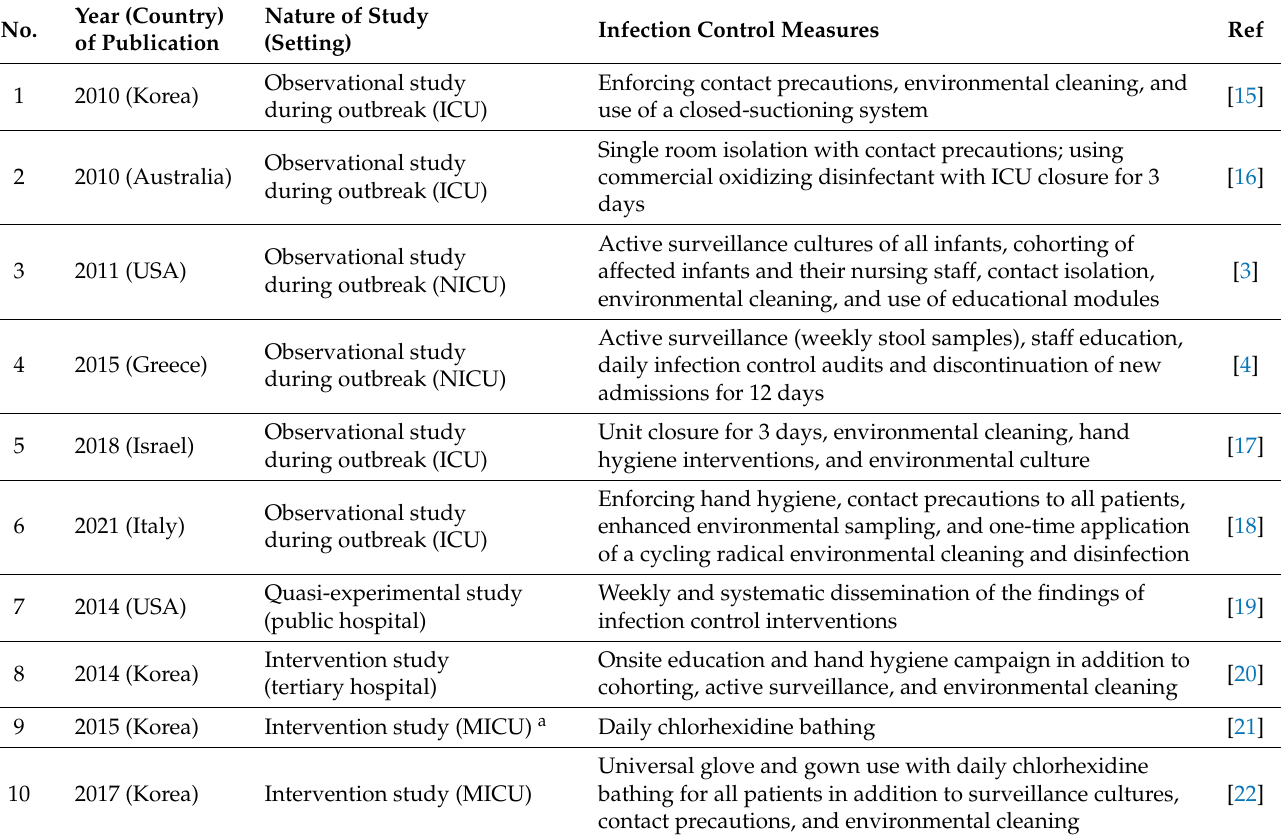
Table 2. Successful experiences of controlling carbapenem-resistant Acinetobacter baumannii (CRAB) in outbreak and non-outbreak